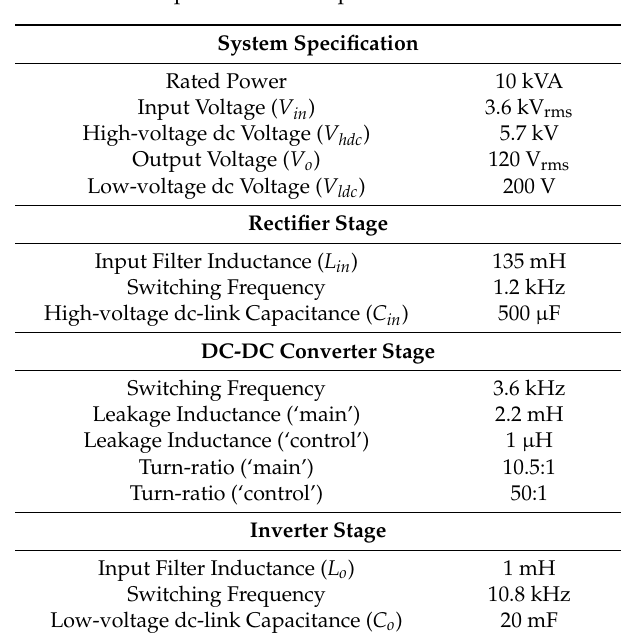
Table 1. Specification and parameters of the